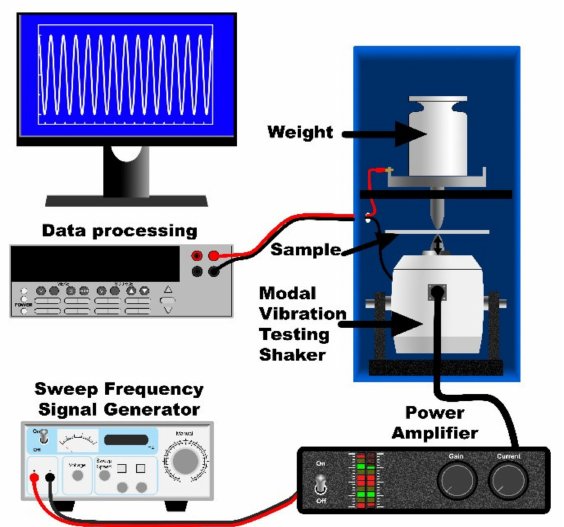
Scheme 1. Schematic illustration of the measuring setup for d33 piezoelectric charge